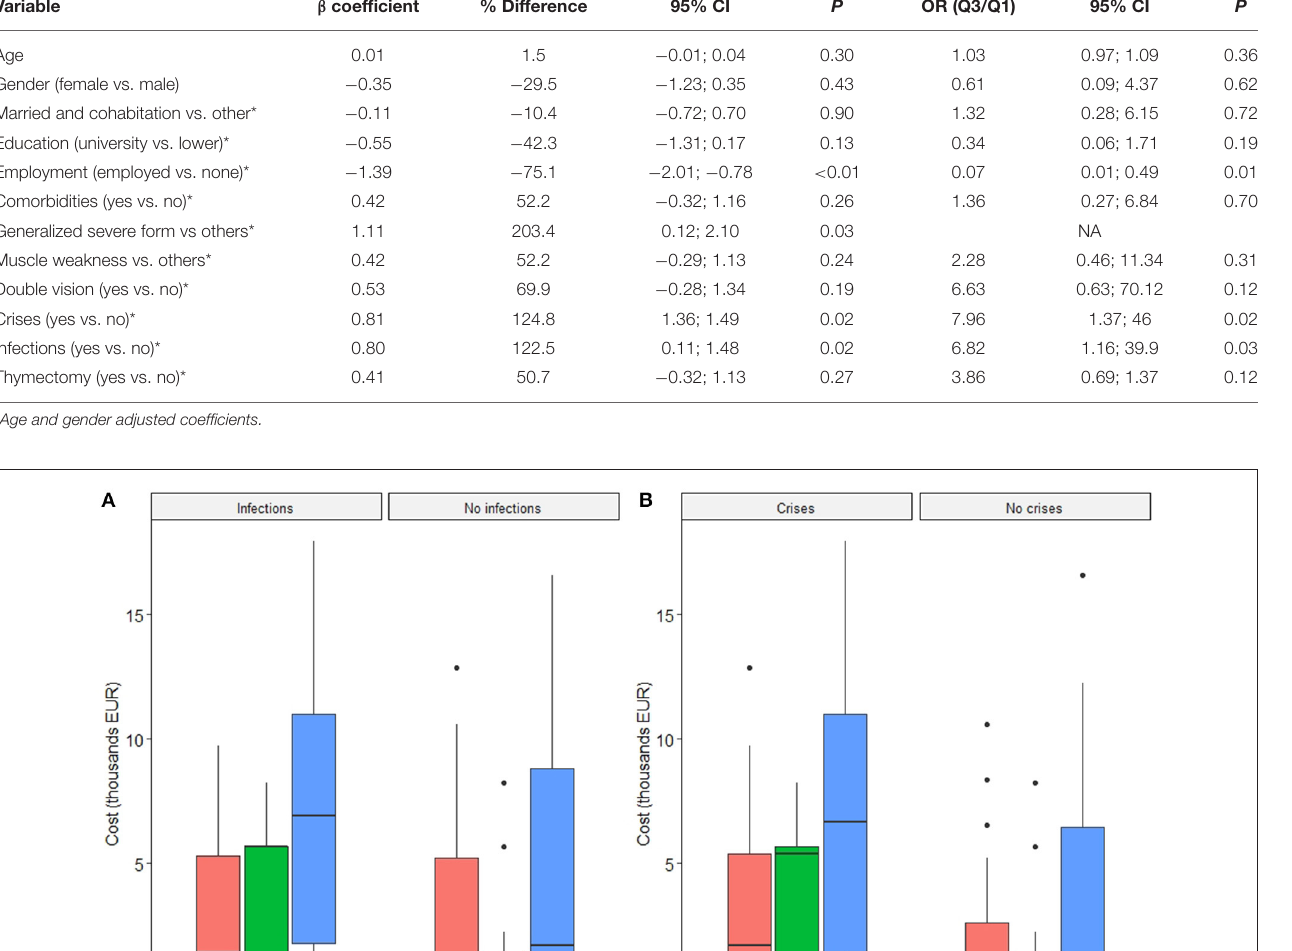
TABLE 4 | Total costs in MG–OLS regression and quartiles logistic regression. Variable